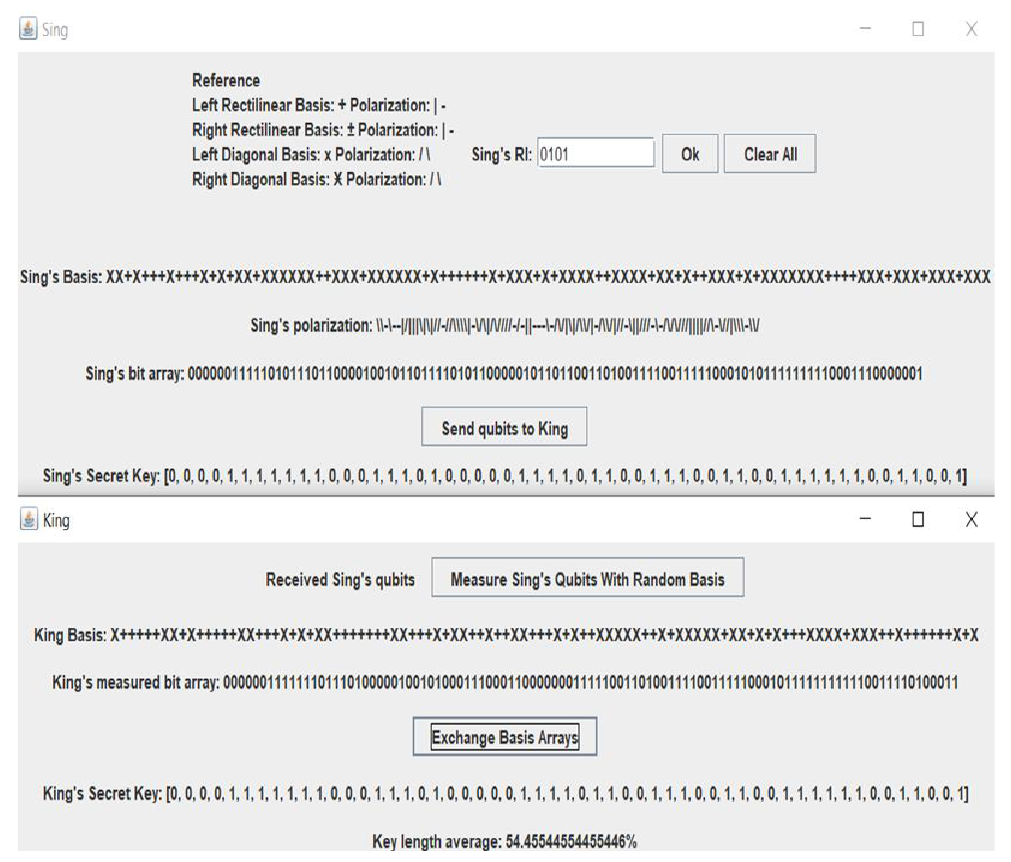
Figure 5. King and Singh interchange base lists and produce a random matched secret key.